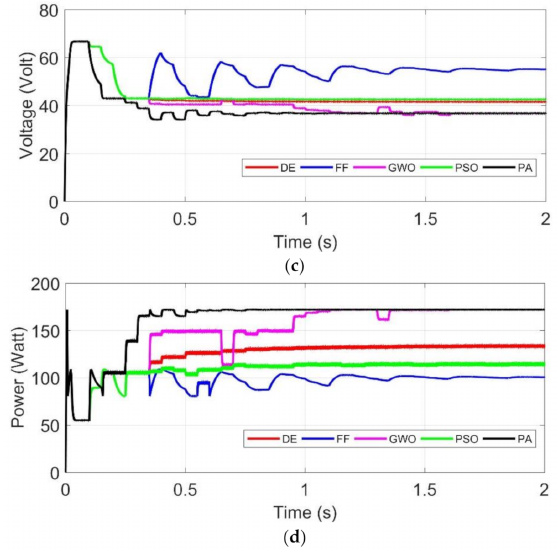
Figure 13. Test 5 ( a ) Initial particles ( b ) Duty cycle (%) ( c ) PV voltage (V) ( d ) PV power